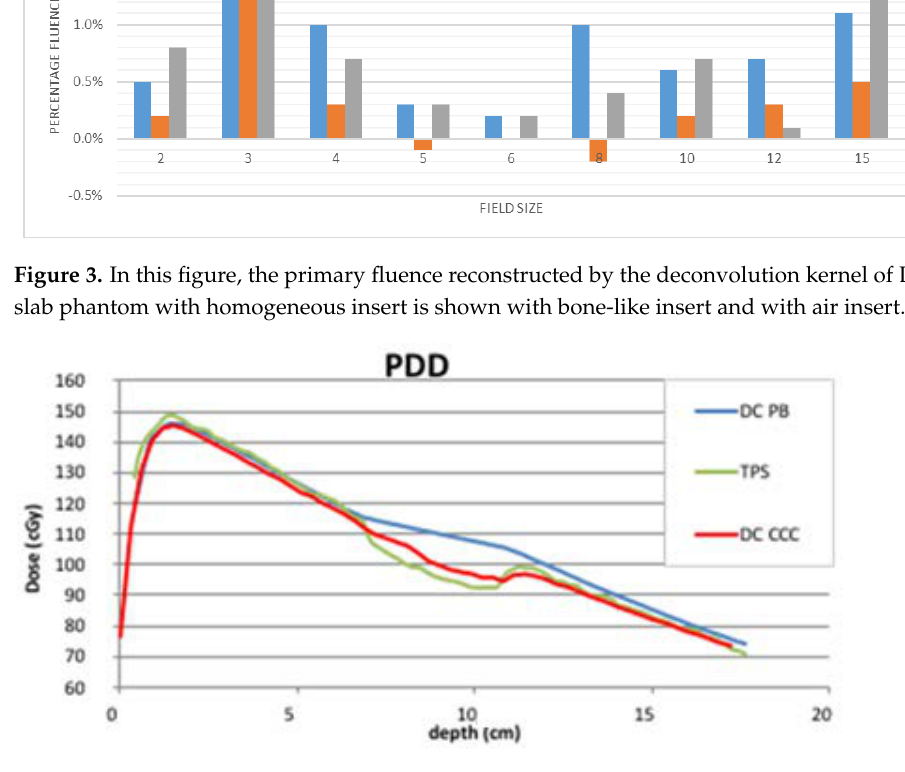
Figure 4. Percentage depth dose (PDD) on the slab phantom with air inhomogeneity on the central axis computed by the treatment planning system Monaco 5.11 with MonteCarlo algorithm and re- constructed with the pencil beam (PB) algorithm and the Collapsed Cone Convolution algorithm of the EPID algorithm Dosimetry Check 5.8.